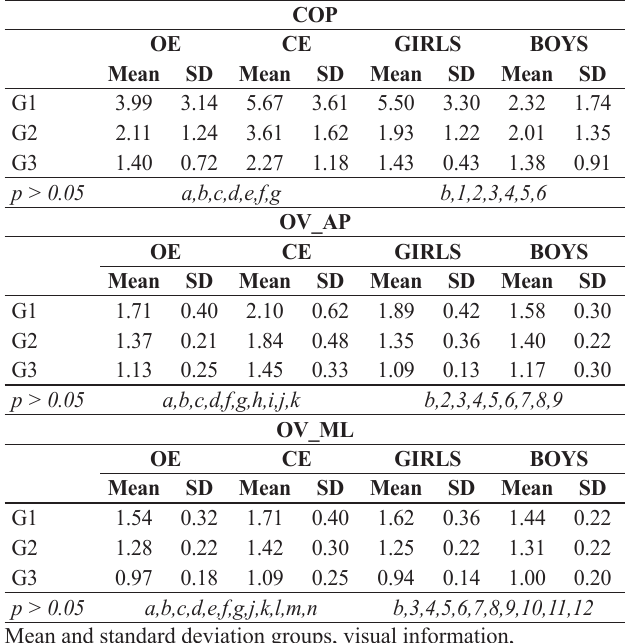
Table 1. PC performance according to age regardless of visual infor- mation and sex: intergroup and intragroup